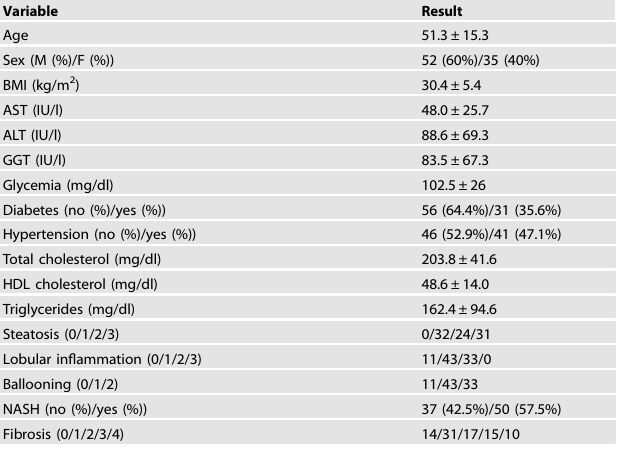
Table 1. Epidemiological, clinical, biochemical and histological characteristics of NAFLD patients.